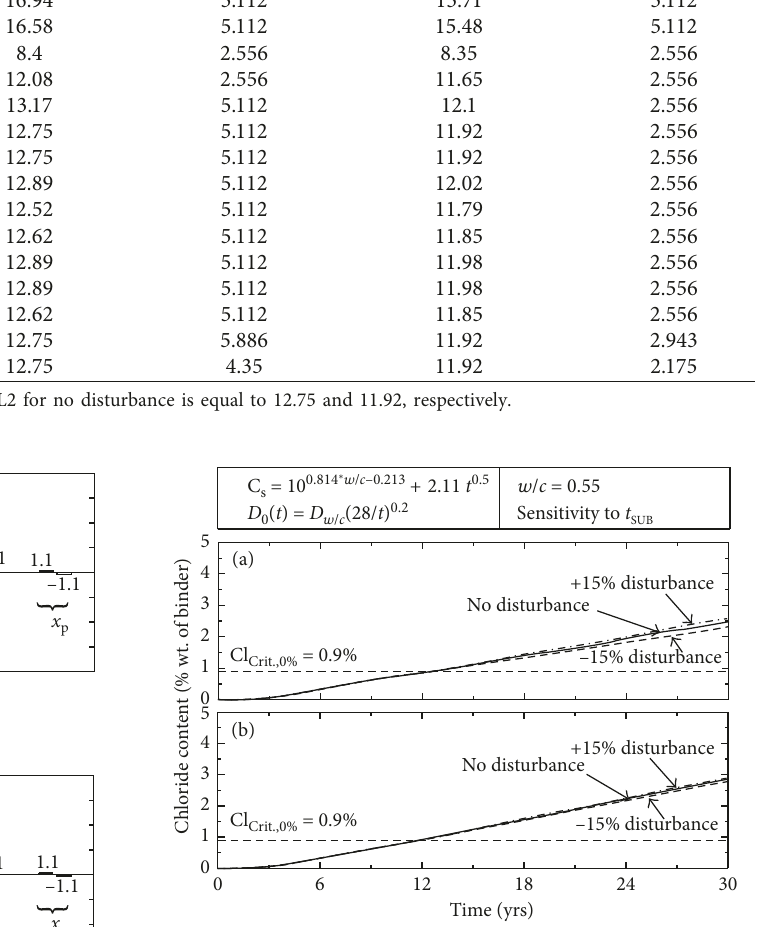
Table 4: Service life and cumulative CO Sensitivity parameters